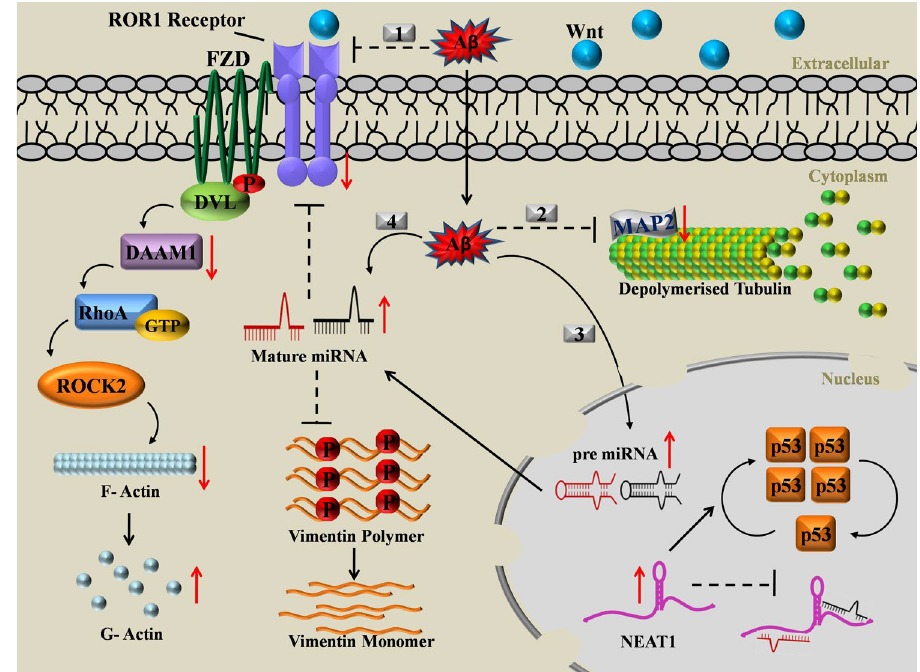
Figure 6. Graphical Abstract: Cartoon representation of the molecular events cascade on exposure to Aβ 1–42 in neuronal cells. Aβ 1–42 has multifaceted effects on cells-1. Extracellular Aβ 1–42 inhibits the levels of microtubule associated RTK ROR1, both at the transcript and protein levels thereby affecting the planar cell polarity pathway leading to the alteration of F:G actin dynamics. 2. Cytosolic Aβ 1–42 affects microtubule dynamics by deregulation of MAP2. 3. Nuclear translocated Aβ 1–42 up regulates the precursor miRNAs and NEAT1. Up regulated NEAT1 in the nucleus exerts a protective role by repressing miRNAs and stabilising p53. 4. The compounded effect of cytosolic and nuclear Aβ 1–42 affects the mature miRNA pool, which targets and co-represses ROR1